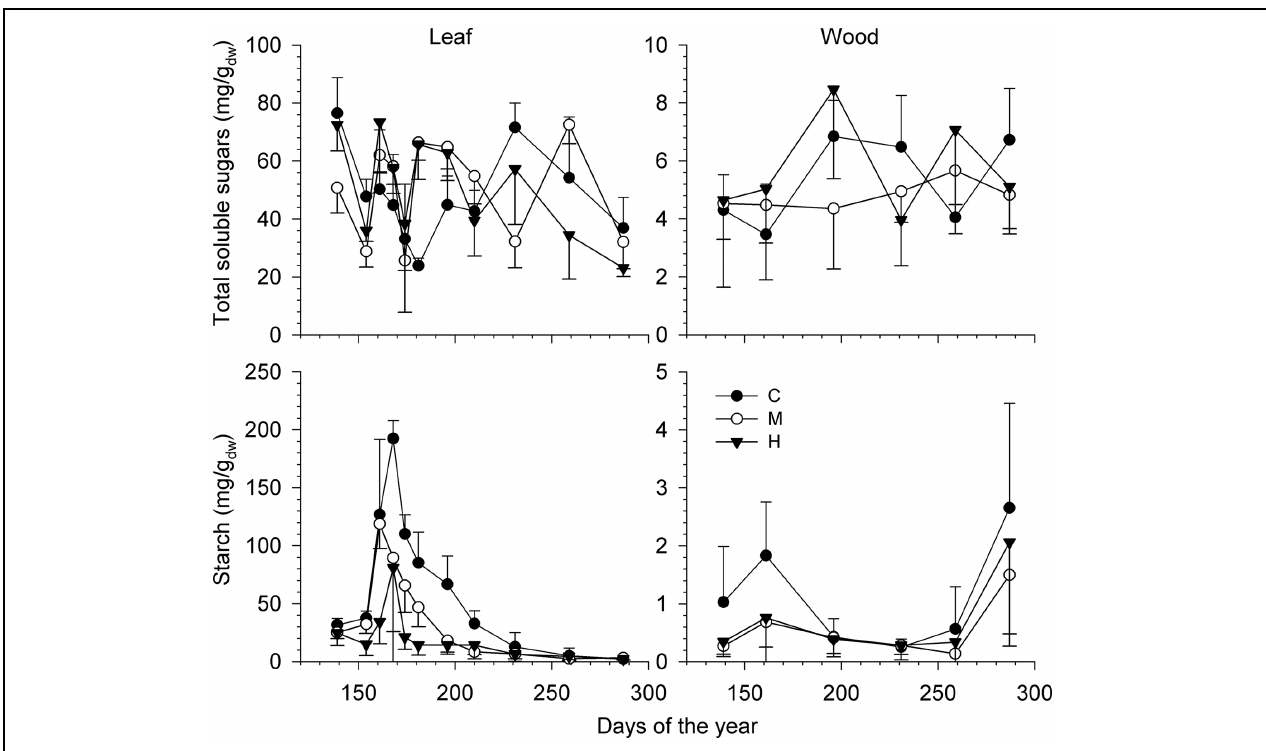
FIGURE 5 | Variation in the soluble sugars and starch (mg/g dw ) measured in leaf (Right) and stem wood (Left) during the growing season for the different defoliation classes (C, control trees; M and H are moderately and heavily defoliated trees). Vertical bars represent the SD calculated among six trees. Note the different ranges of the vertical